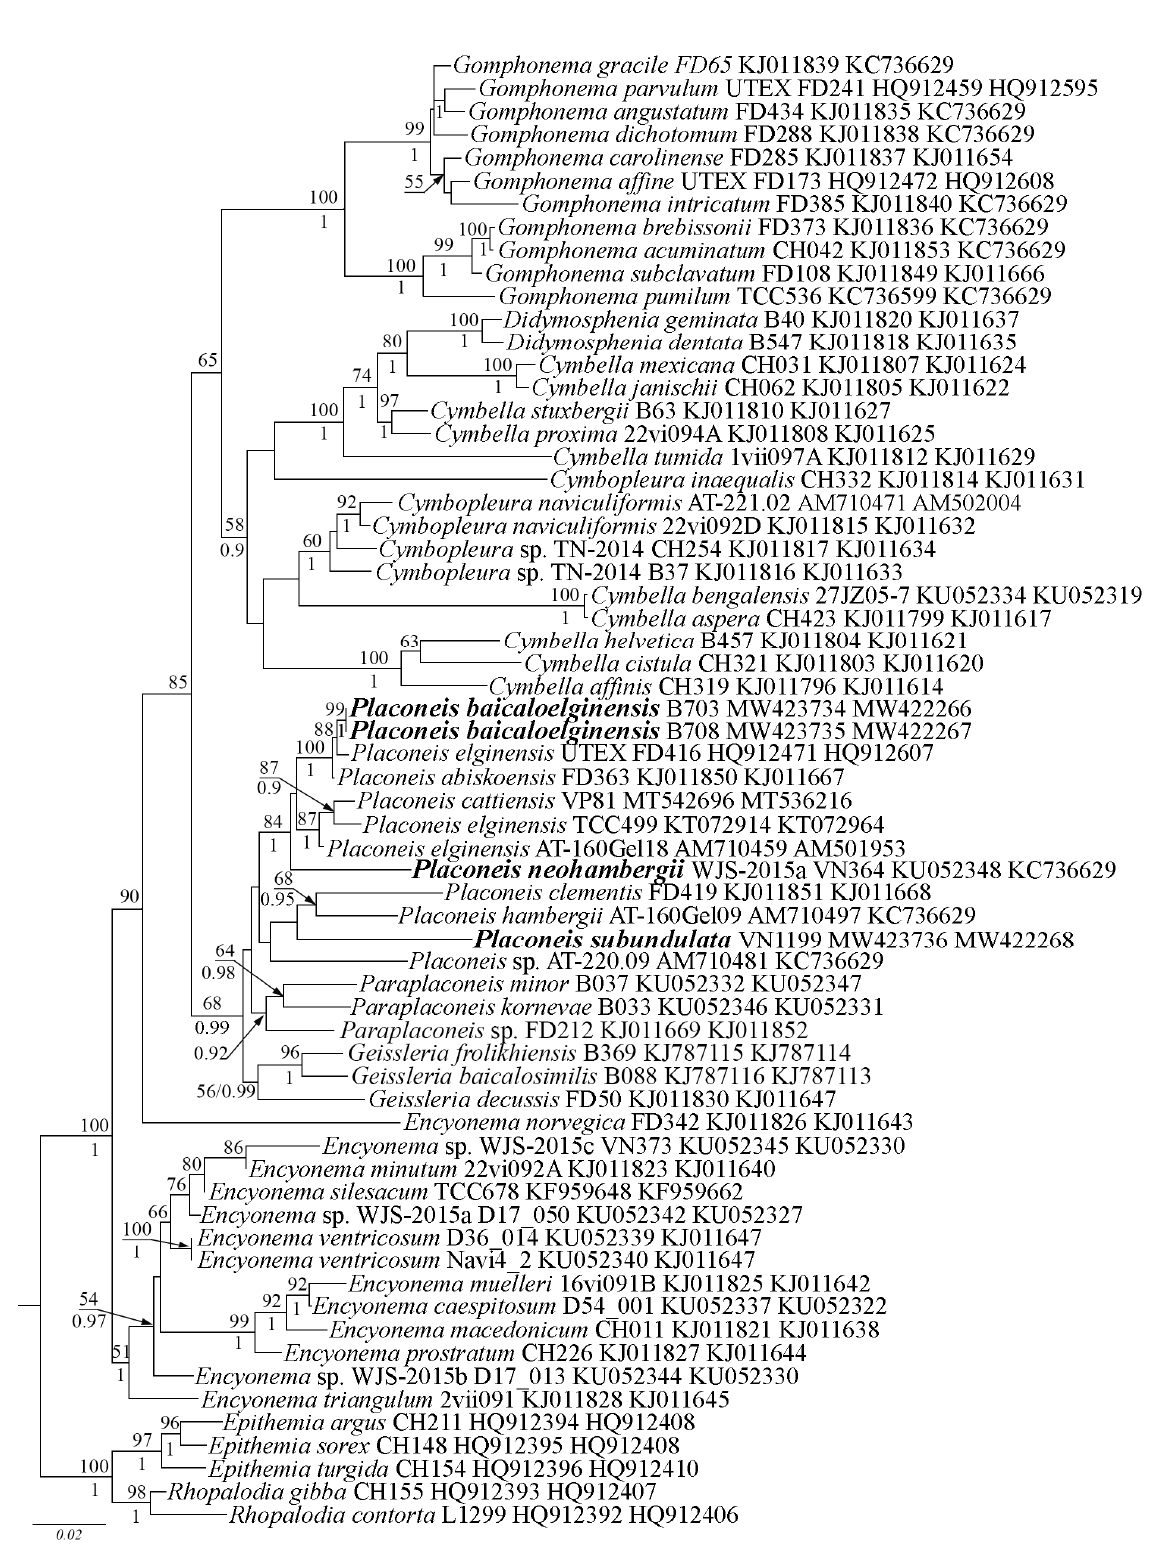
Figure 5. Maximum likelihood tree for Placoneis baicaloelginensis sp. nov., Placoneis neohambergii sp. nov. and Placoneis subundulata sp. nov. (indicated in bold) constructed from a concatenated alignment of 64 partial rbc L and partial 18S rDNA sequences of 1540 characters. Values above the horizontal lines (on the left of slash) are bootstrap support from ML analyses (<50 are not shown); values below the horizontal lines (to the right of slash) are Bayesian posterior probabilities (<0.9 are not shown). All sequences have strain numbers (if available) and GenBank numbers. Species from Rhopalodiaceae were used as an outgroup. * is 100 statistical support.